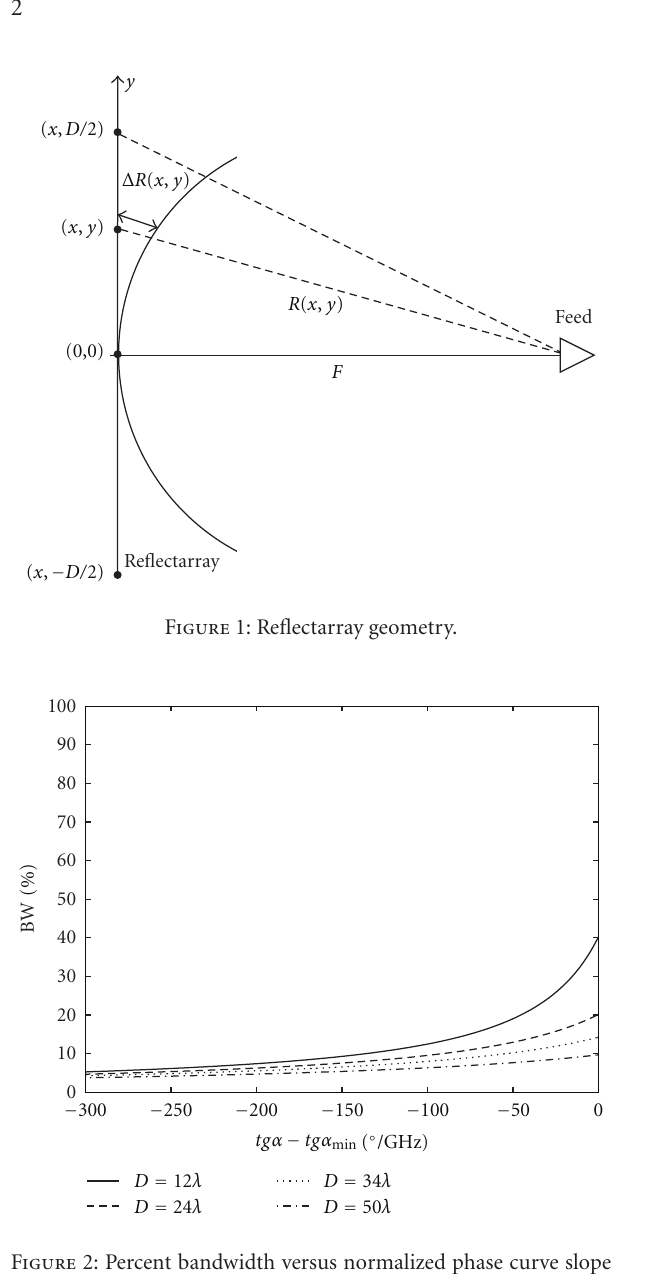
Figure 4: Percent bandwidth versus element phase curve slope for di ff erent array diameters ( F/D = 1 .